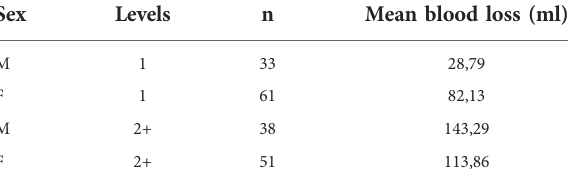
TABLE 1 Blood loss in patients in the “ one-level ” and “ two-plus ” level groups.